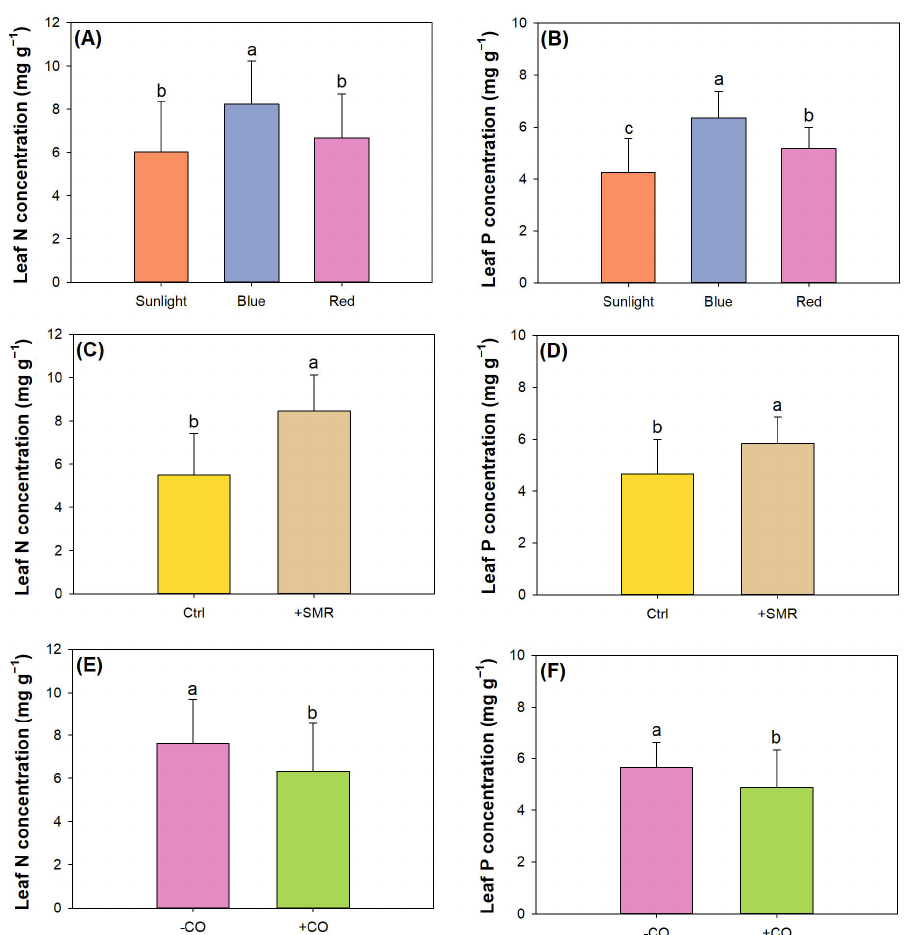
Figure 3. Leaf nitrogen (N) and phosphorus (P) concentrations in black chokeberry ( Aronia melanocarpa (Michx.) Elliott 1821) exposed to separate light-type (sunlight, blue light-emitting diode (LED), red LED), chitosan oligosaccharide (CO), and spent mushroom residue (SMR) treatments: ( A ) light effect on leaf N concentration; ( B ) light effect on leaf P concentration; ( C ) SMR effect on leaf N concentration with unamended soils as the control (Ctrl); ( D ) SMR effect on leaf P concentration with unamended